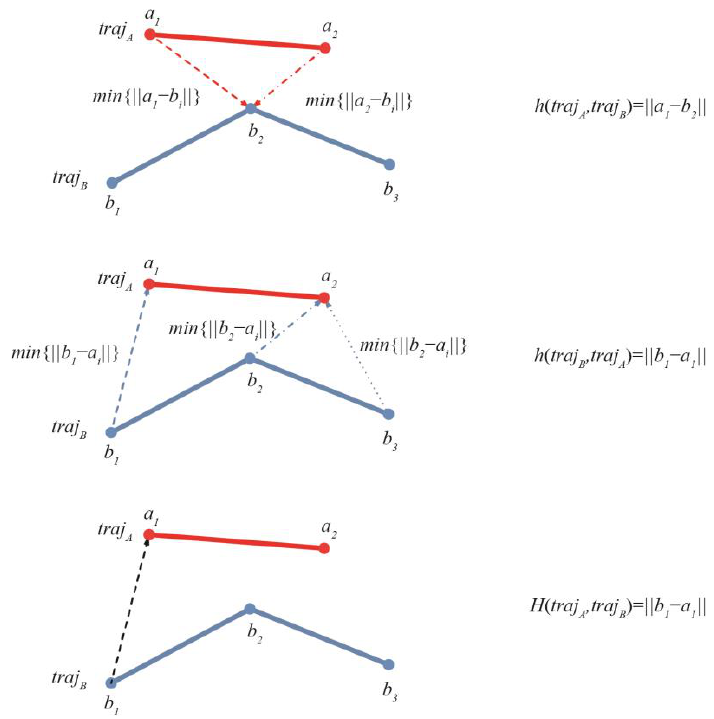
Figure 6. Schematic diagram of Hausdorff distance. Table 3. Hausdorff distance matrix of ship trajectories from Kaohsiung Port to Xiamen Port.